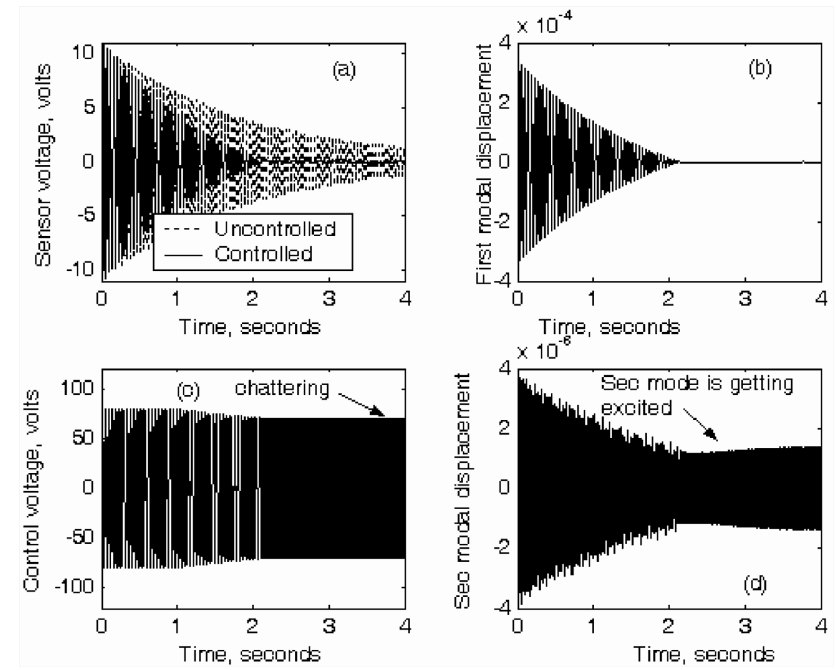
Fig. 6. SMC without boundary layer (a) sensor voltage, (b) first modal displacement, (c) actuator voltage and (d) second modal